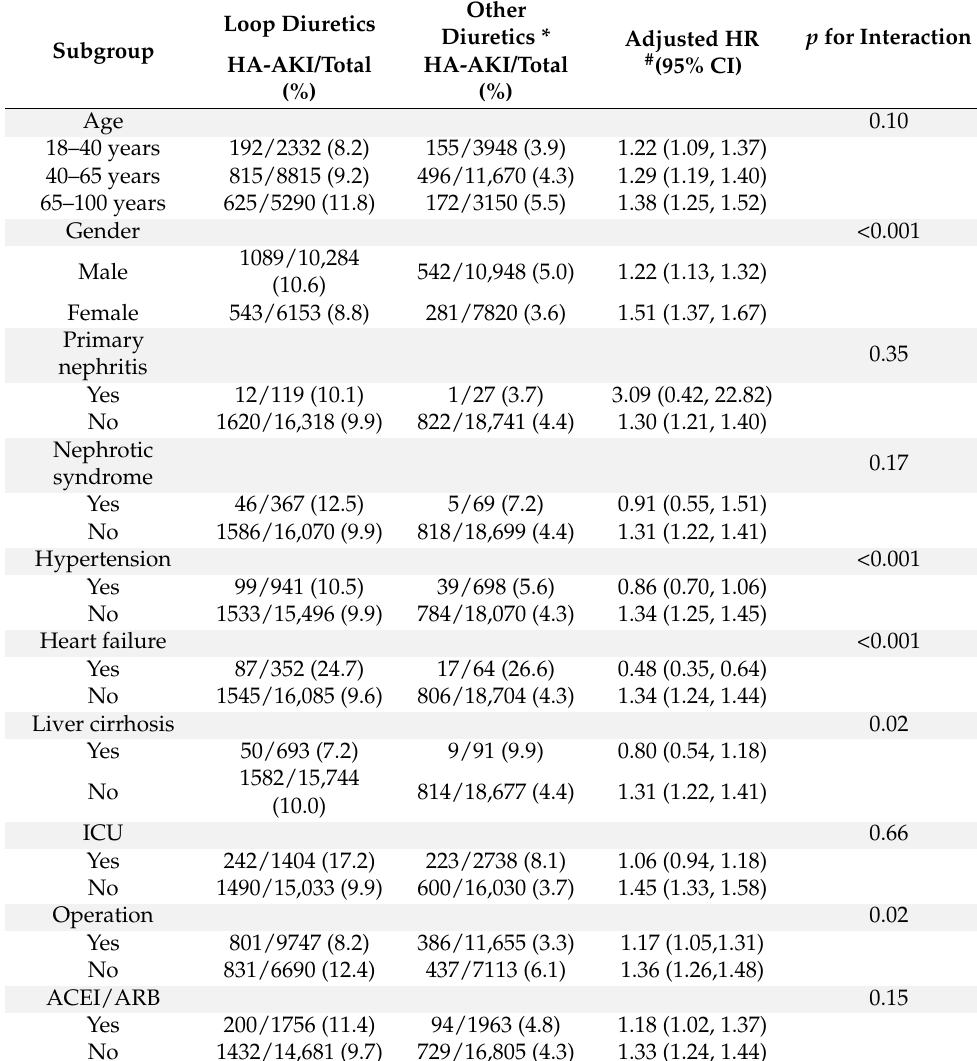
Table 3. The association between loop diuretics versus other diuretics and the risk of HA-AKI in various